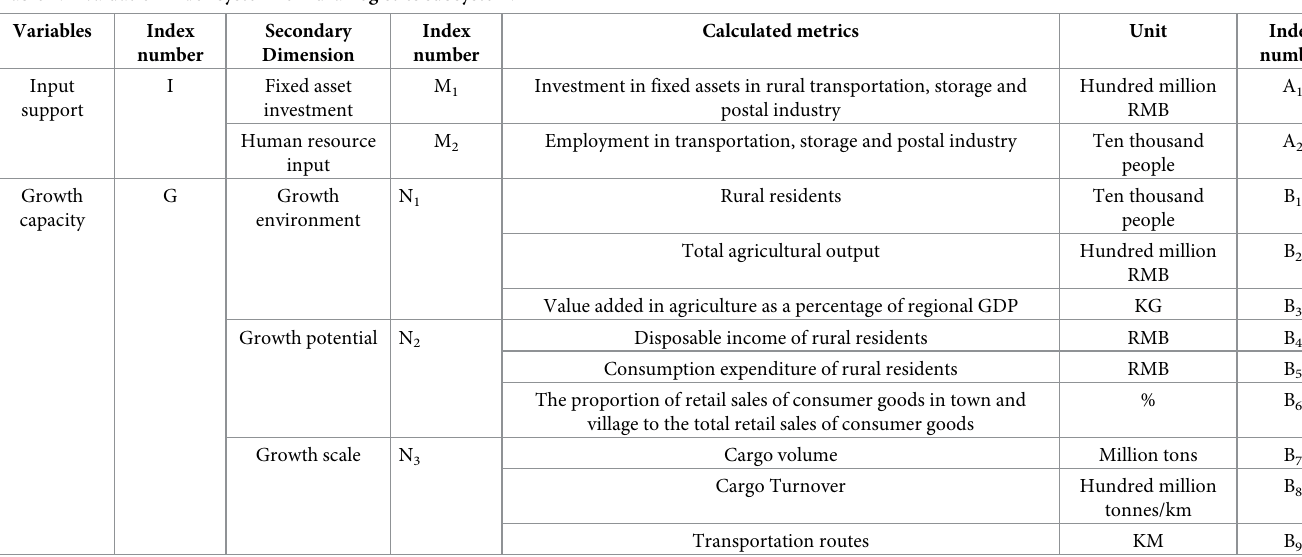
Table 1. Evaluation index system for rural logistics